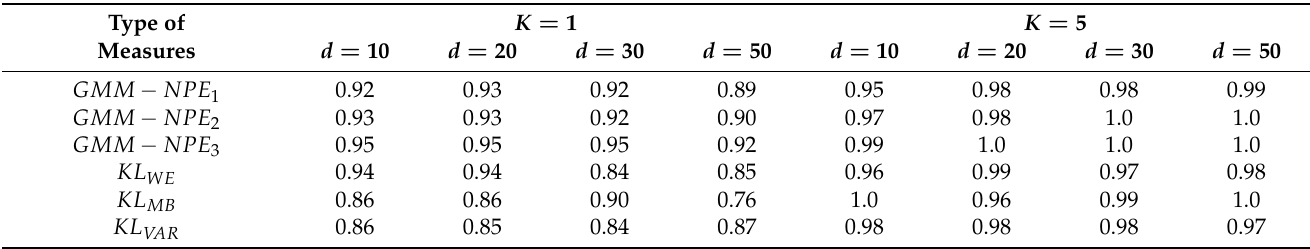
Table 7. Results in the form of recognition accuracy, obtained on the synthetic data: l = 2, t 1 , t 2 ∈ [ − 3,5 ] , N = 800, M = 200, m 1 = 0, m 2 = 10 h , with h = [ h 1 , . . . , h d ] T , h i ∼ U ([ 0,1 ]) , i = 1, . . . , d .